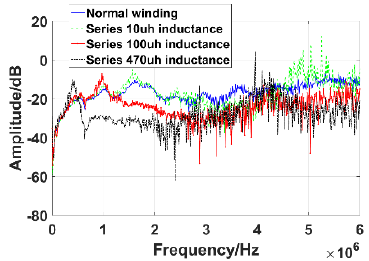
Figure 15. Experimental results.